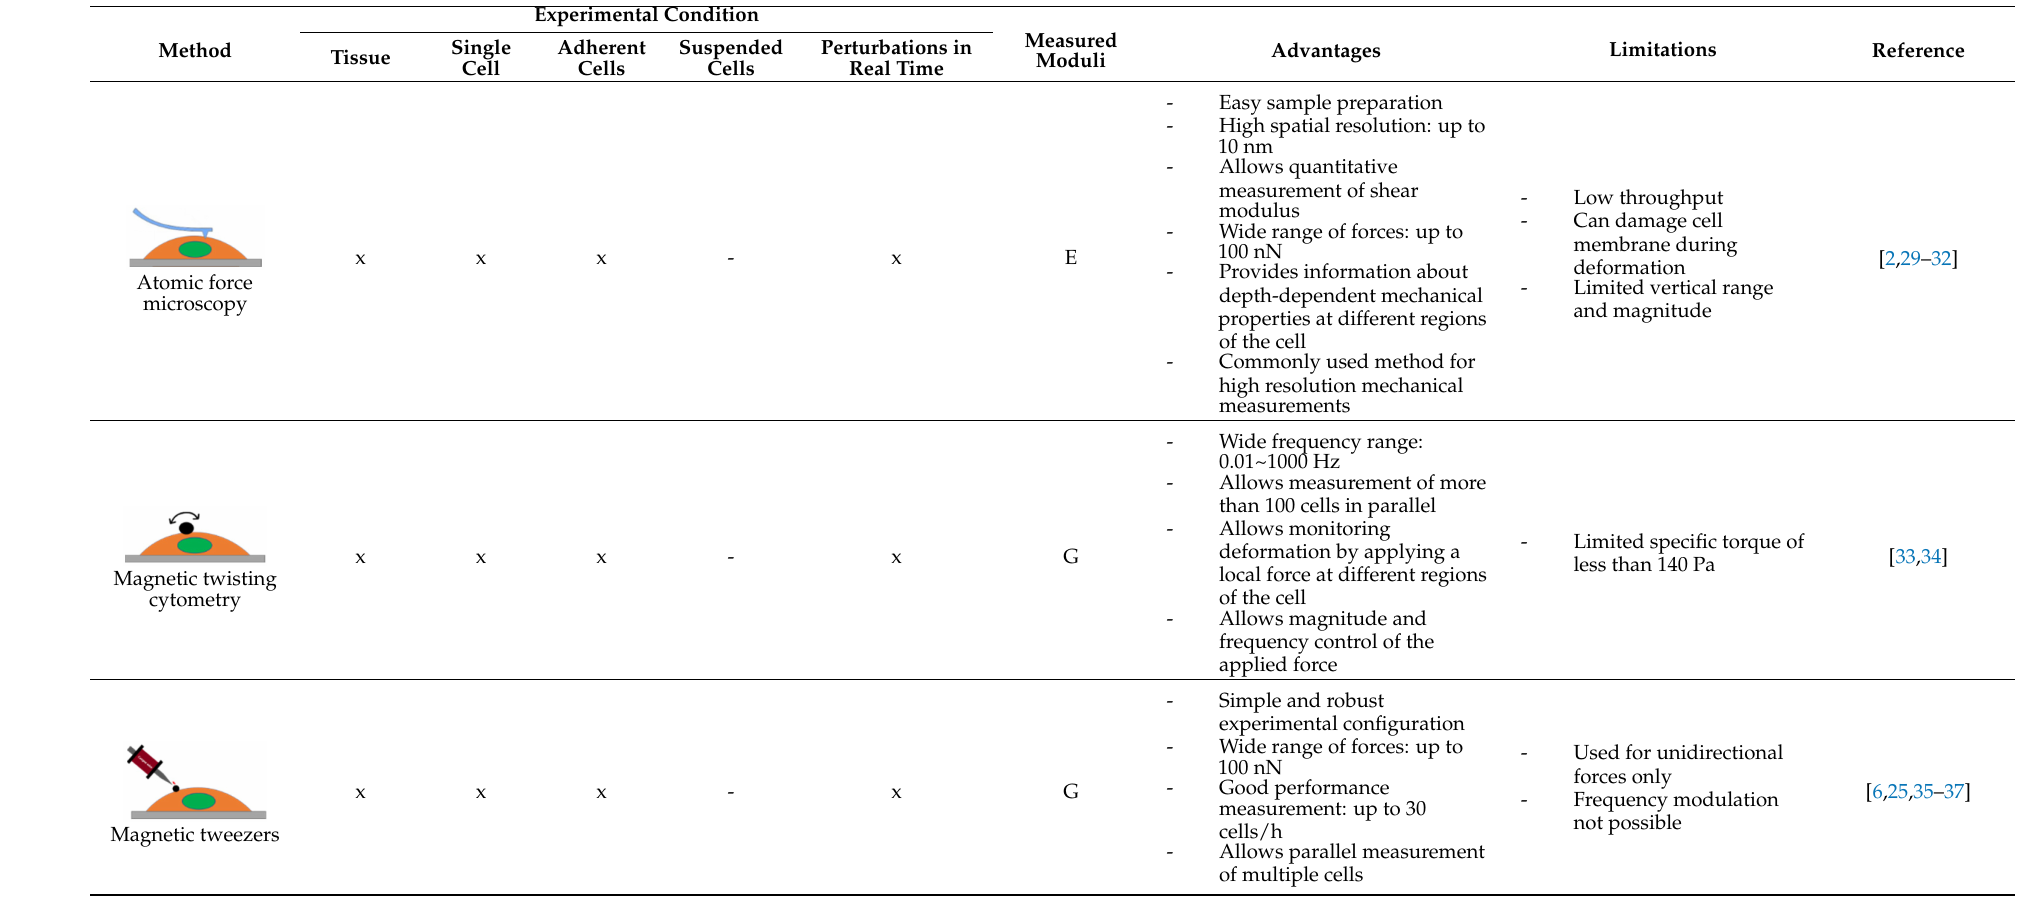
Table 1. Comparison of common methods for measuring cell mechanical